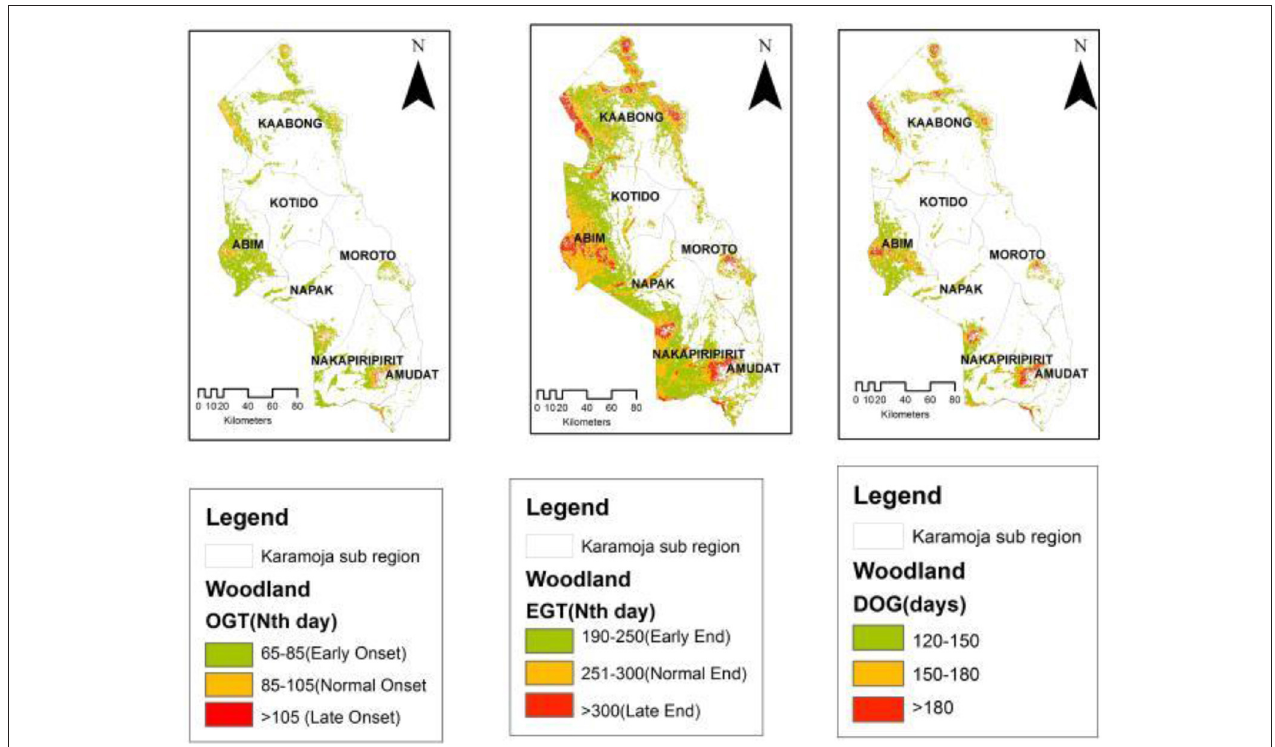
FIGURE 6 | Woodland OGT, EGT, and DOG spatial